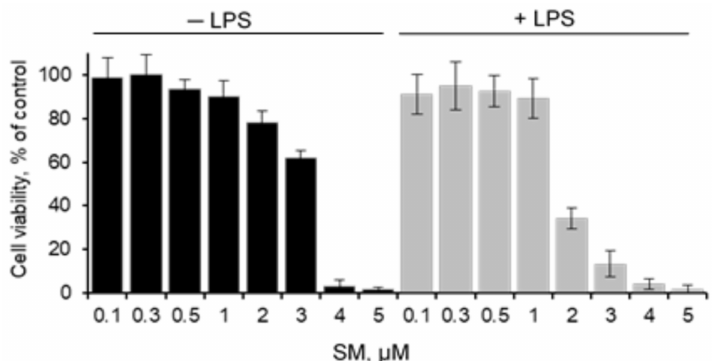
Figure 2. E ff ect of SM on the viability of RAW 264.7 macrophages. Cells were incubated with various concentrations of SM in medium supplemented or not with lipopolysaccharide (LPS) (1 µ g / mL) for 24 h. Cell viability was assessed using the MTT assay, and the results are expressed as the percentage of viable cells in comparison with the viability of control (untreated cells). Values are expressed as the mean ± SD of three independent